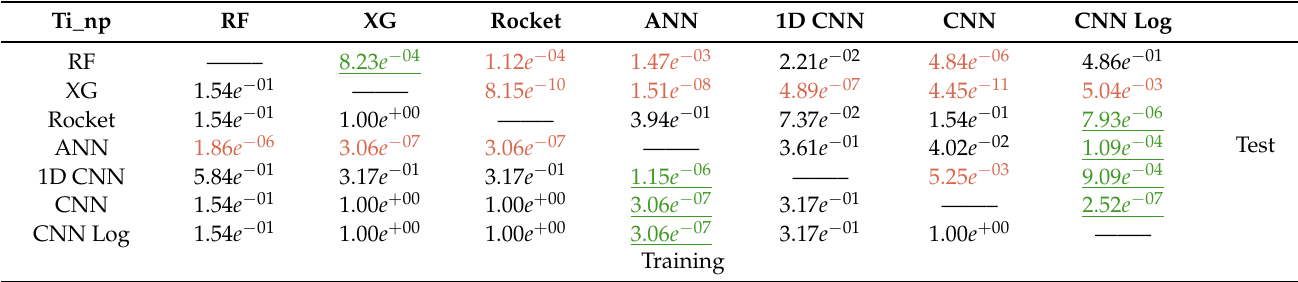
Table A12. Kruskal–Wallis p -values comparing all methods of the Ti_np concentration prediction task. Above the diagonal, we have the results for the test set, and below for the training set. Significant results ( p < 0.01) are represented in green or red when the method on the left is significantly better or worse, respectively.